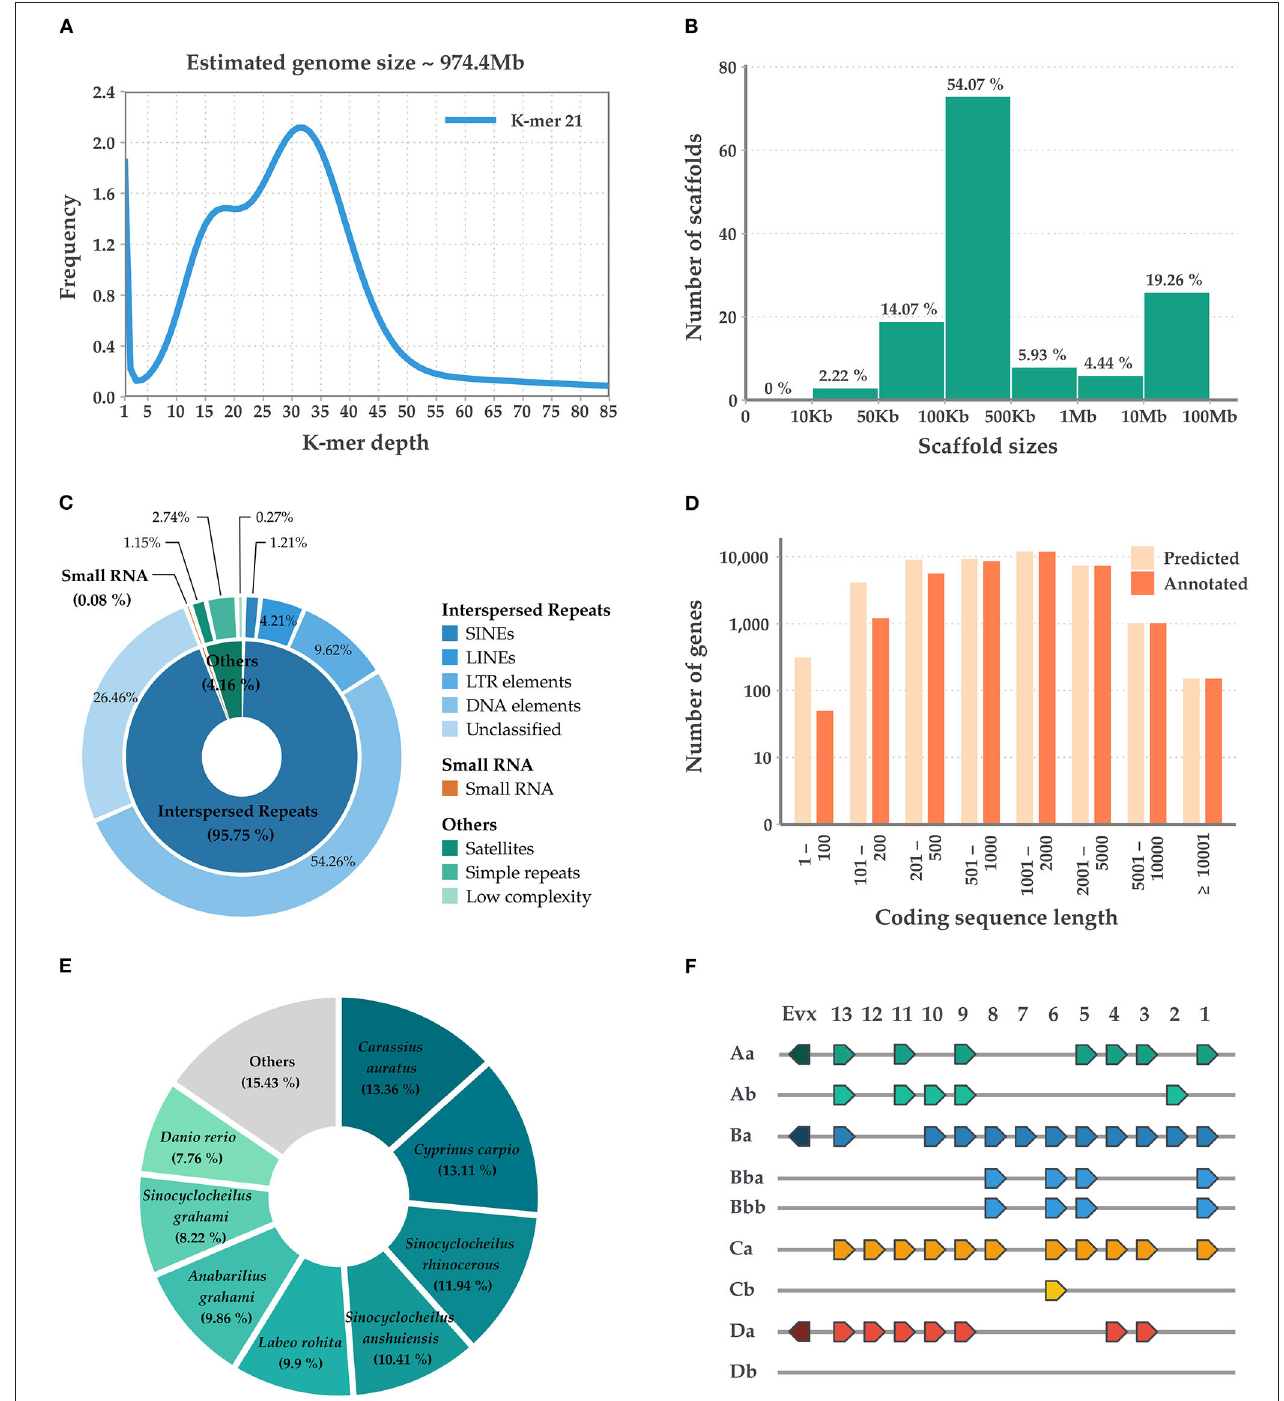
FIGURE 1 | Summary of the sequencing, assembly, and annotation of the Misgurnus mizolepis draft genome. (A) K -mer-based genome size estimation; (B) Length distribution of the assembled scaffolds; (C) De-novo repeat prediction for three classes (inner circle) and their sub-classes (outer circle); (D) Length distribution of predicted, functionally annotated genes; (E) Species distribution of the top NCBI-NR BLAST hits; and (F) Hox gene clusters.